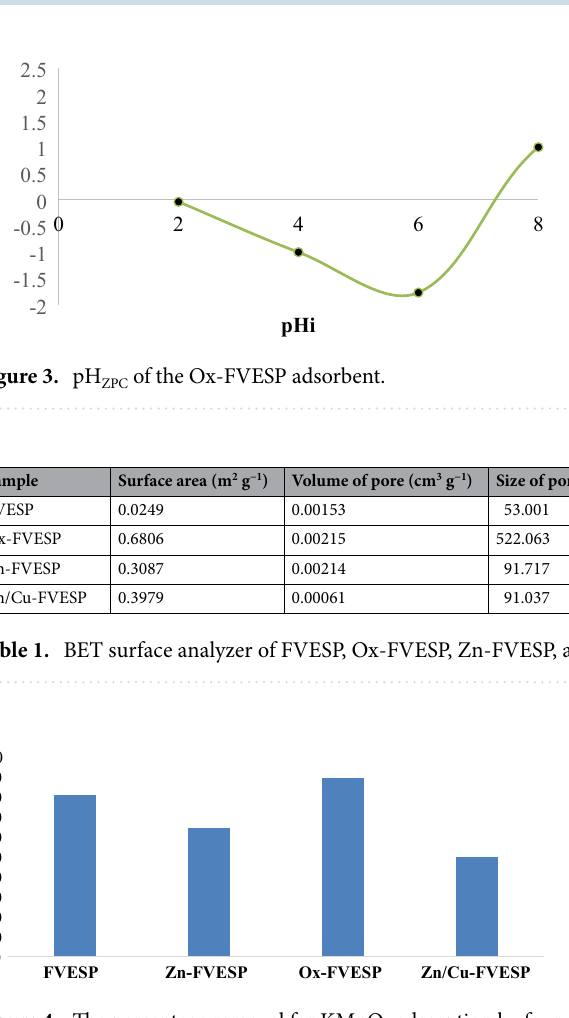
Figure 4. The percentage removal for KMnO 4 adsorption by four different samples.